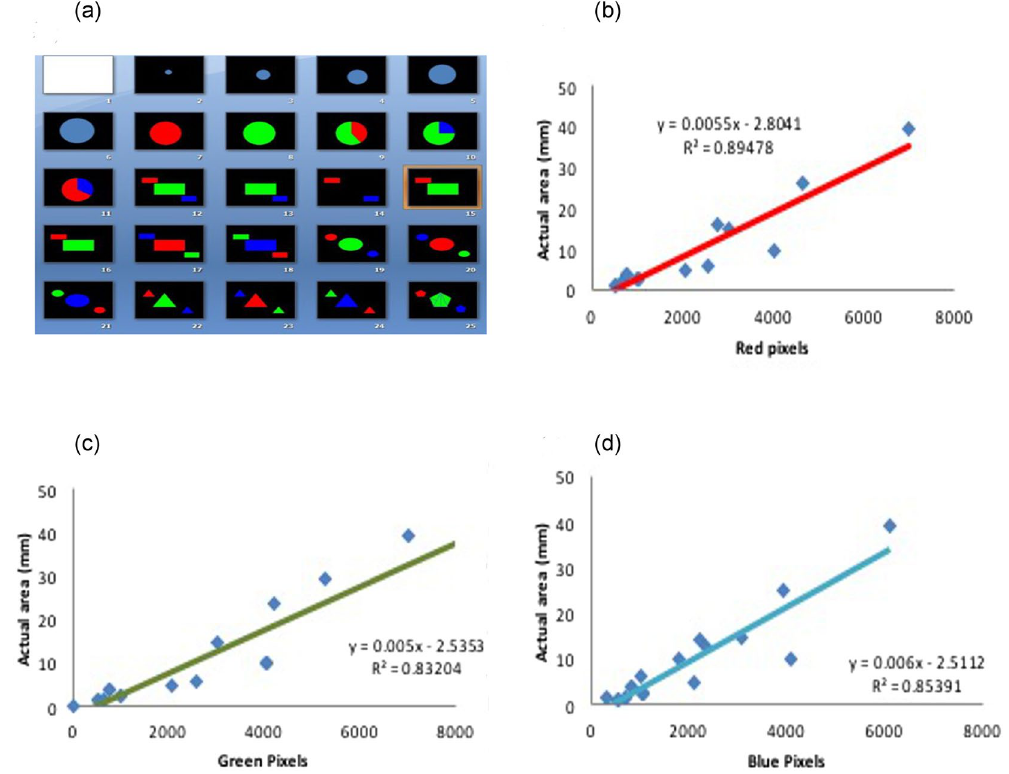
Figure 1. Combined figure showing schemes of primary colours (red, green and blue) and their combinations/ mixtures ( a ) used for the standardization of image analysis software. Standard curves representing actual colour area vs number of colour pixels for red ( b ), green ( c ) and blue ( d ) after the standardization of RGB image analysis